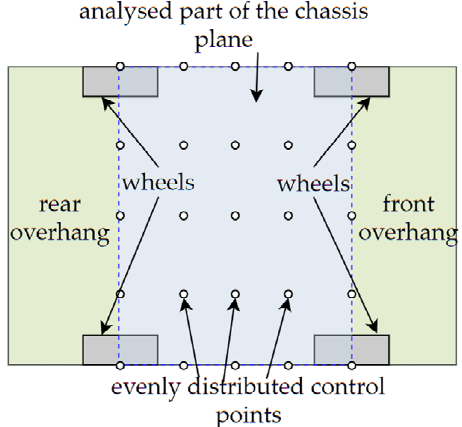
Figure 9. Evenly distributed control points in the analyzed part of the chassis plane (bird’s eye view).